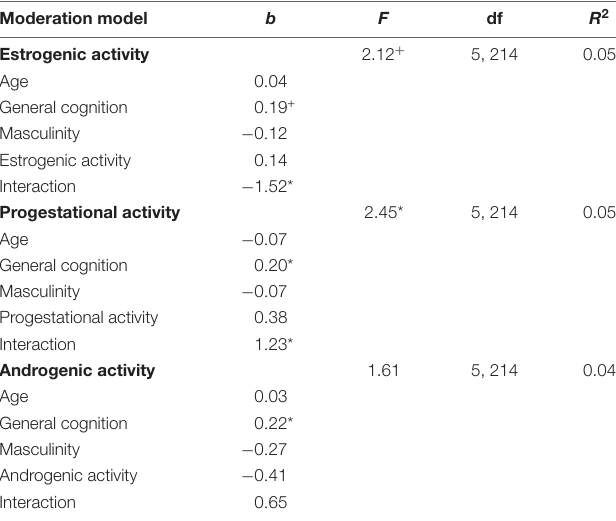
TABLE 2 | Results of moderation analyses examining whether sex hormone activity in OCs moderates the link between masculinity and mental rotations